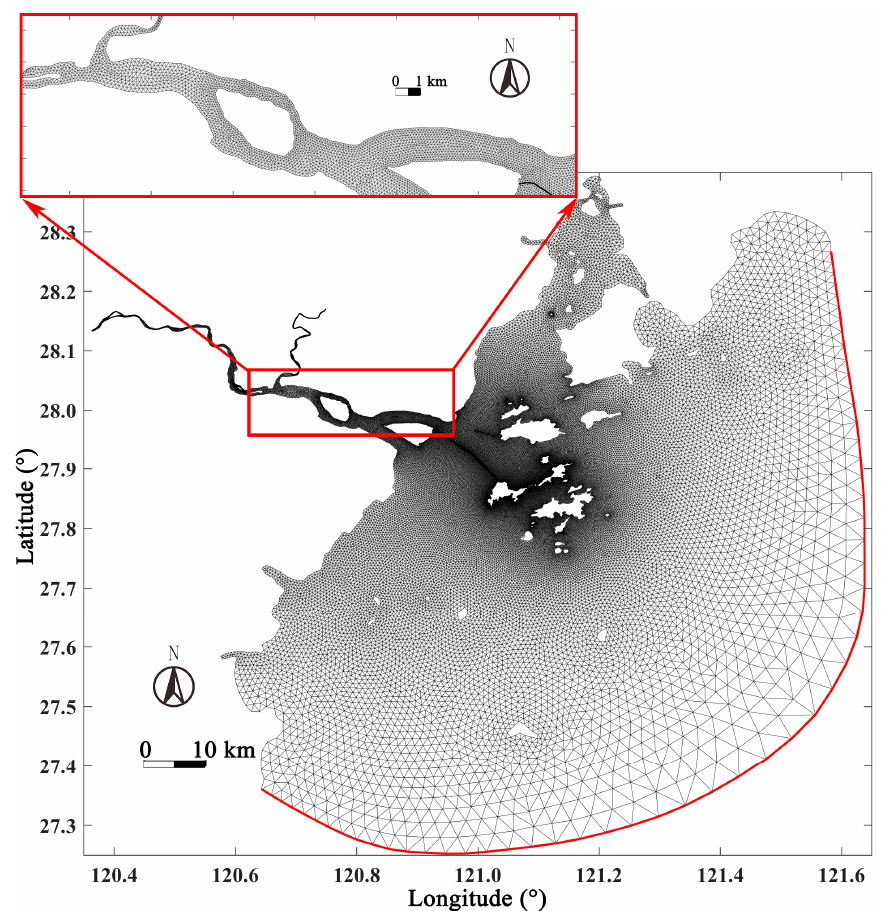
Figure 2. Mesh grid of the ORE model used in this study. Red curve indicates open boundary. Table 1. Parameters used in the suspended sediment transport model.